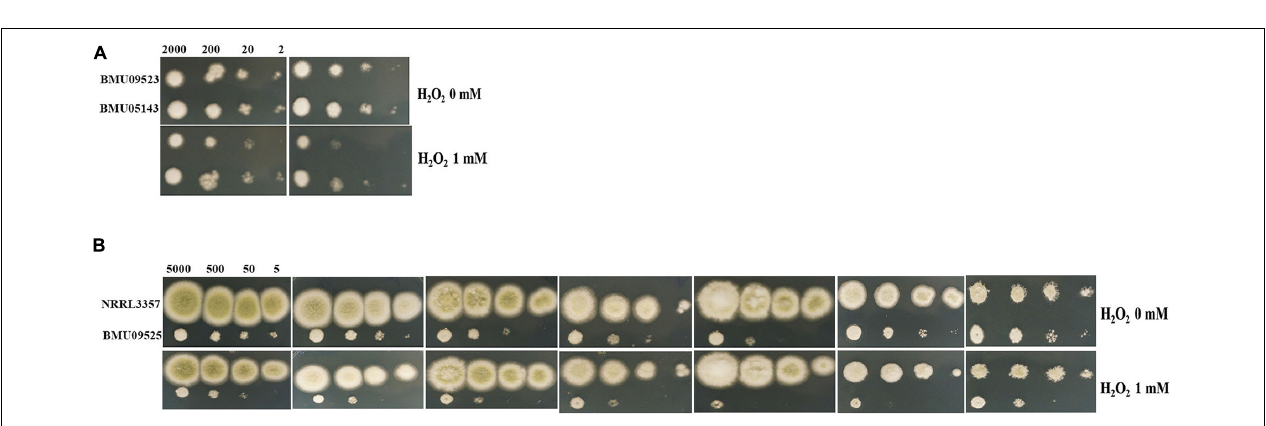
FIGURE 1 | In vitro antifungal susceptibility testing. (A) In vitro antifungal susceptibility testing determined by disk diffusion. The antioxidant N-Acetylcysteine (NAC) was added at a concentration of 15 mM. Disks of AMB (50 µ g), ITC (10 µ g), VRC (5 µ g), POS (5 µ g), CAS (5 µ g), and MFG (5 µ g) were placed onto the NMH medium. Plates were incubated at 35 ◦ C for 48 h. (B) In vitro antifungal susceptibility testing determined by E-test. Plates were incubated at 35 ◦ C for 48 h.